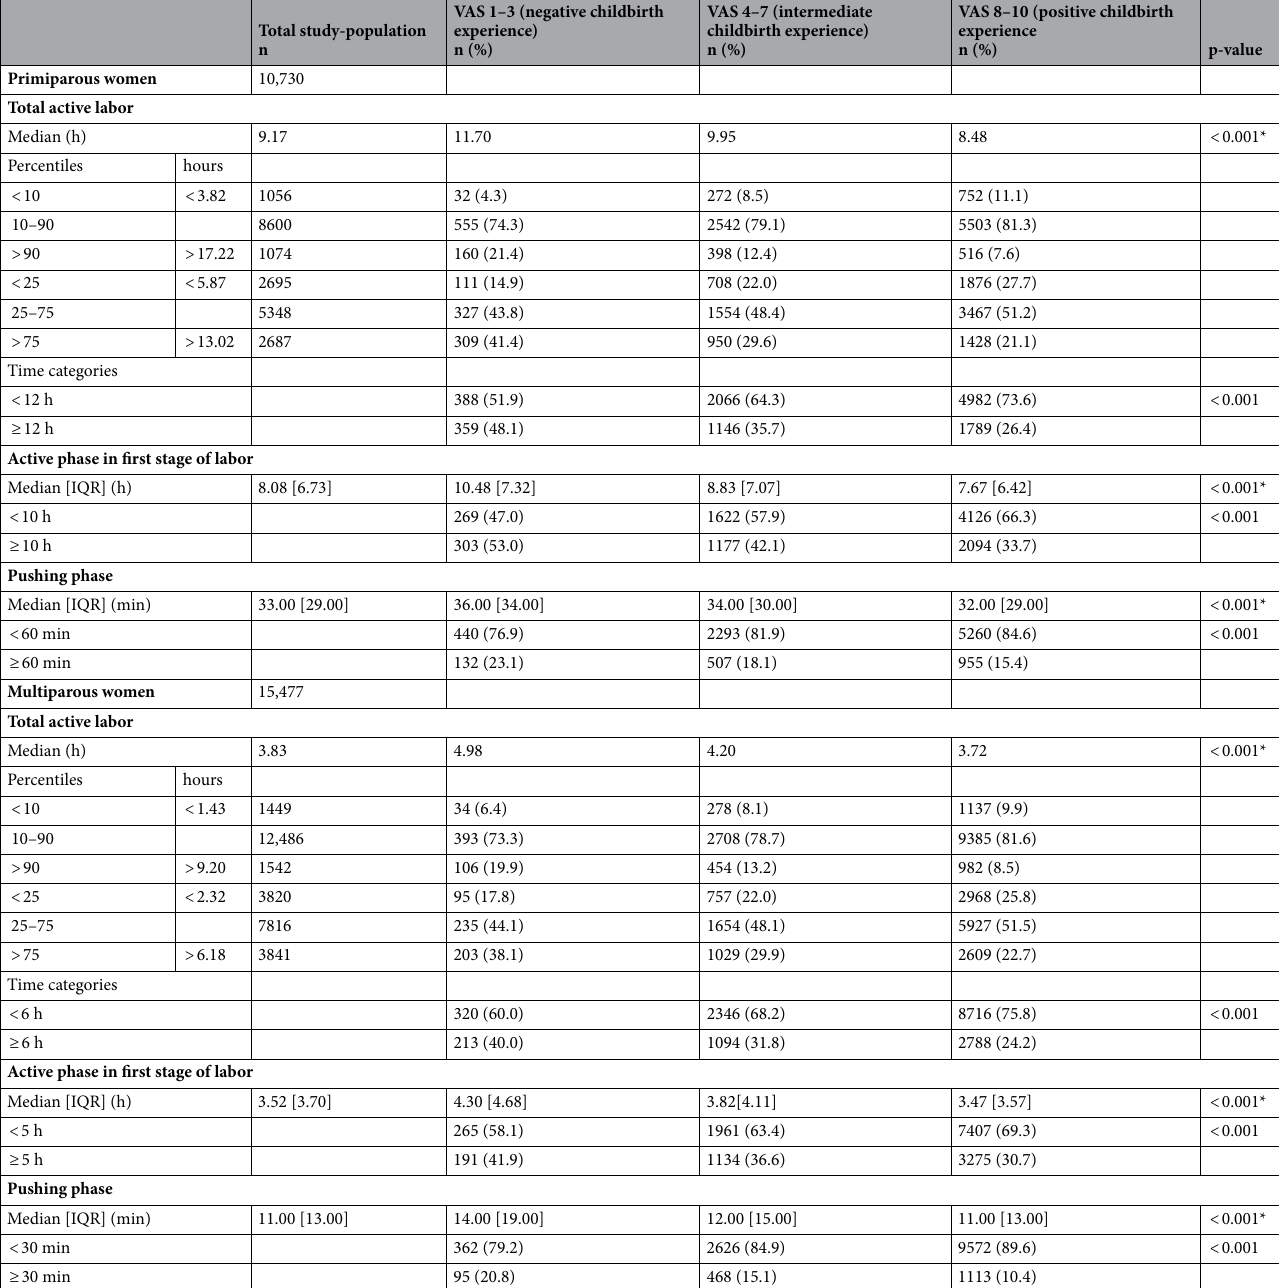
Table 2. Duration of labor and childbirth experience in primiparous and multiparous women. VAS visual analogue scale, h hours, min minutes. Categorical data are presented as number and (%) and continuous data as median [IQR]. P-values < 0.05 were considered statistically significant. *P-value for Kruskal–Wallis